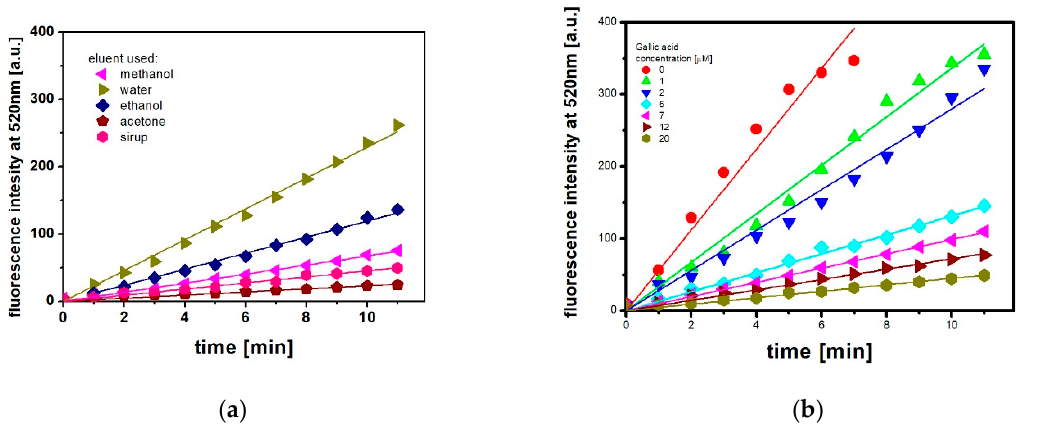
Figure 6. Time changes of DCF fluorescence maximum ( λ ex = 490 nm; λ obs = 520 nm); ( a ) for water extract solutions; ( b ) for gallic acid water solutions. Table 3. Antioxidant efficiency of examined extracts with standard deviation.